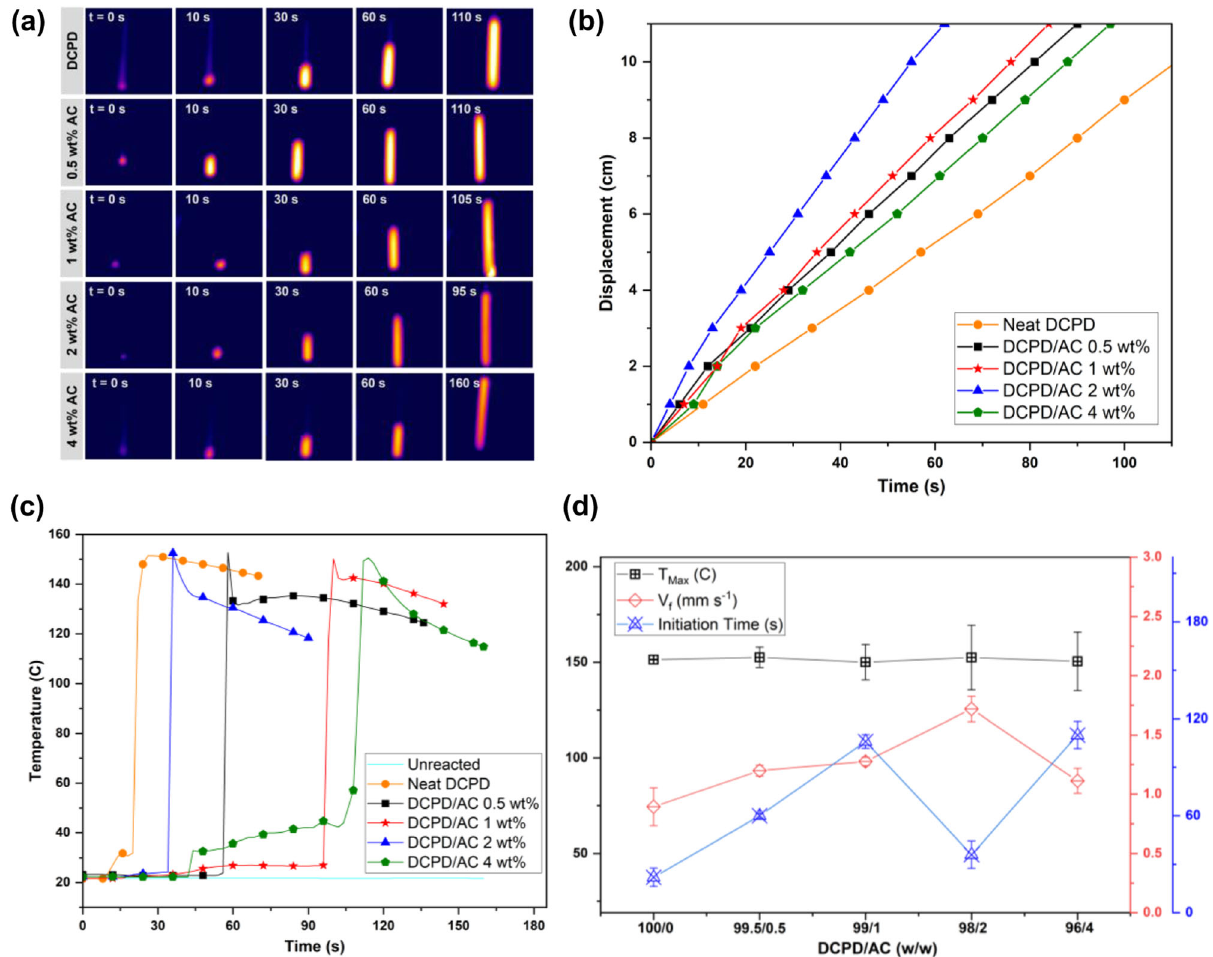
Fig. 5 Evaluation of the reaction kinetics observed during FP of the DCPD/AC mixtures. a For increasing AC wt%, the reaction lasted for shorter amounts of time. b Front velocities of each reaction were obtained by plotting front displacement against time. c The temperature vs. time plots exhibited negligible changes in maximum temperature with increasing AC wt%. On the other hand, a general trend of increasing reaction initiation time was observed with increasing AC wt%, with the exception of 2 wt% AC. d Reaction kinetics of 2wt% AC was highlighted as it exhibited the most rapid front velocity and shorter reaction initiation time, respectively, amongst the tested specimens. Standard deviations of the obtained values ( T Max , v f , and t init ) are shown as error bars. Table 3 Front velocity (v f ), maximum temperature ( T Max ), and initiation time ( t init ) values were obtained during frontal polymerization of the DCPD/AC